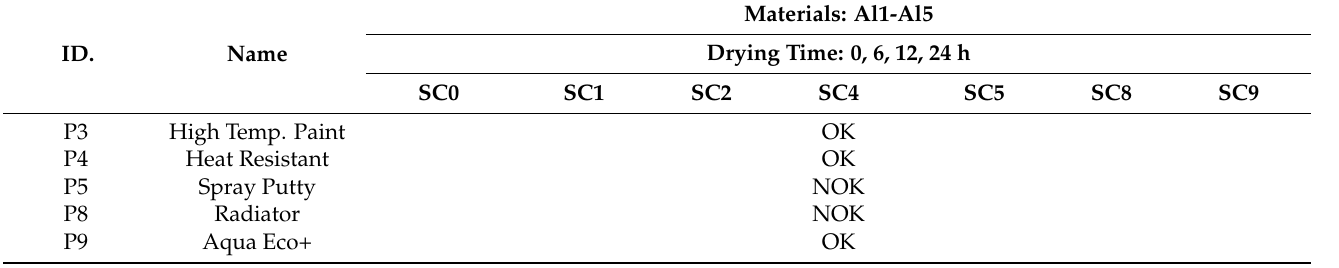
Table 8. Results of the bending test.